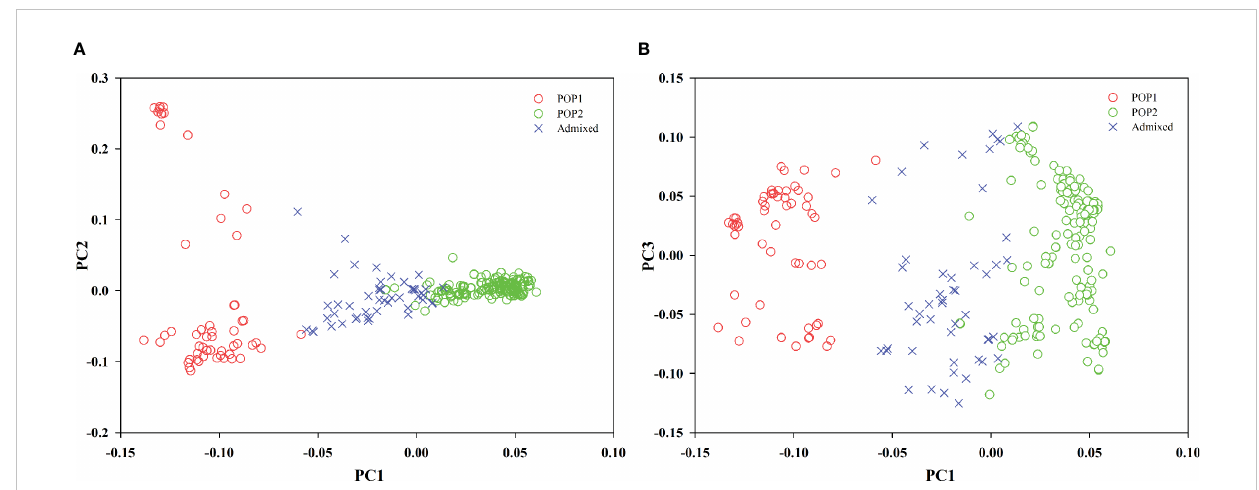
FIGURE 3 Scatterplots showing the results of principal component analysis (PCA) conducted based on the SNP marker data of oat lines labeled according the different subgroups identi fi ed by STRUCTURE (membership coef fi cient ≥ 0.7). (A, B) Population strati fi cation of oat lines according to the fi rst component PC1 vs. PC2 (A) , and PC1 vs. PC3 (B) . Admixed individuals are indicated with ×.